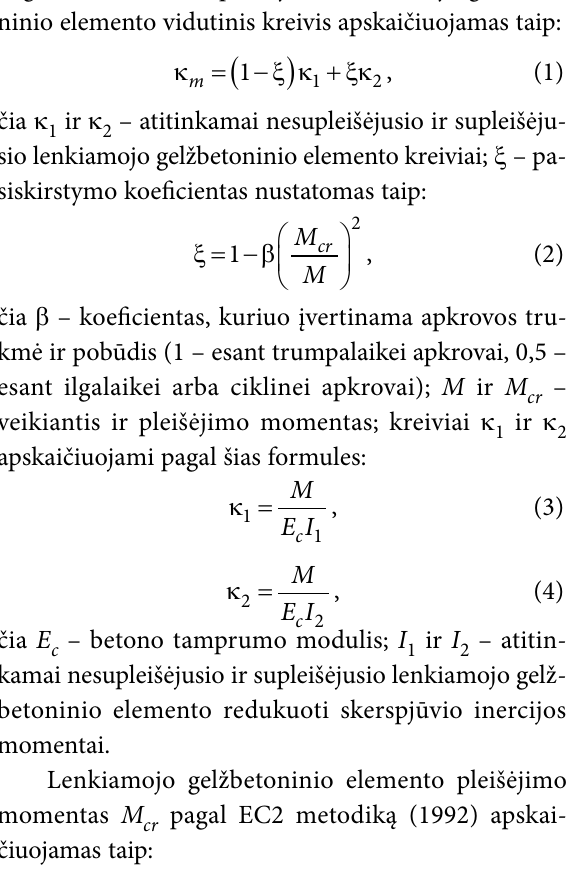
Pastabos: - skaičiuojant imti pastovūs dydžiai; - dydžiai, pagal kuriuos sudaryti elementų pogrupiai ; - skaičiuojant imti kintami